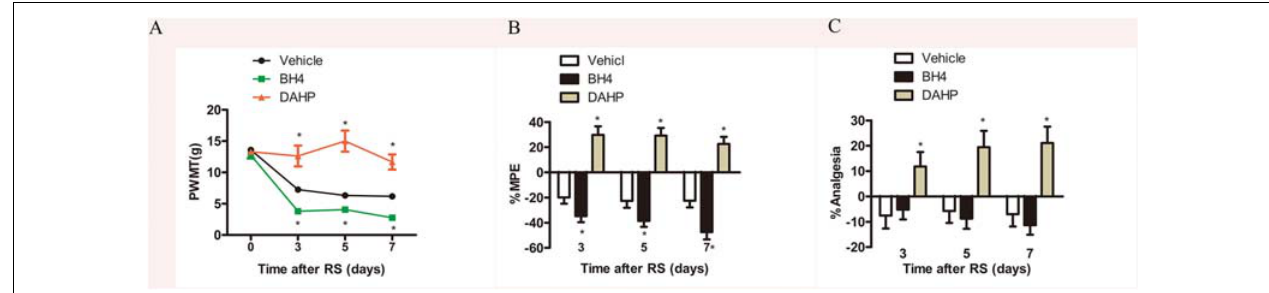
FIGURE 3 | Effects of either DAHP or BH4 intrathecal administration on nociceptive behavior in rats subjected to chronic RS. Chronic RS rats were consecutively administered with either DAHP (6 mg/kg) or BH4 (1 µ g/ml, 10 µ l) as the study protocol in Figure 1 . (A–C) Nociceptive behavior tests including PWMT (treatment: F 2 , 23 = 73.995, P < 0.001; observation intervals: F 3 , 69 = 45.069, P < 0.001; interaction: F 6 , 69 = 11.544, P < 0.0001); (B) treatment: F 2 , 23 = 51.543, P < 0.001; observation intervals: F 2 , 46 = 3.942, P = 0.026; interaction: F 4 , 46 = 0.761, P = 0.556; (C) treatment: F 2 , 23 = 50.134, P < 0.001; observation intervals: F 2 , 46 = 6.665, P = 0.003; interaction: F 4 , 46 = 0.257, P = 0.904. Data are shown as mean ± SEM ( n = 8–10). *Significant difference with respect to vehicle groups (two-way ANOVA with repeated measures in nociceptive behavior tests, followed by Bonferroni post hoc test or Dunnett’s T3 test if necessary, * P < 0.05). BH4, tetrahydrobiopterin; RS, restraint stress; PWMT, paw withdrawal mechanical threshold.